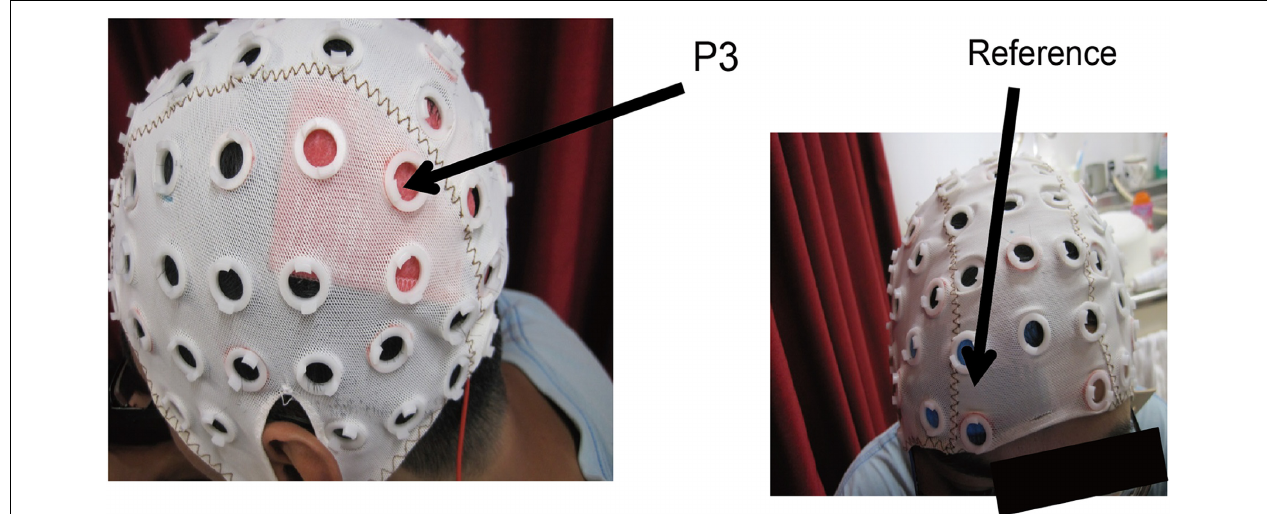
FIGURE 2 | Head locations for the electrodes. The target region was the left posterior parietal cortex where the center of the electrodes was located at P3 in the 10–20 international measurement. The reference patch was located just above the